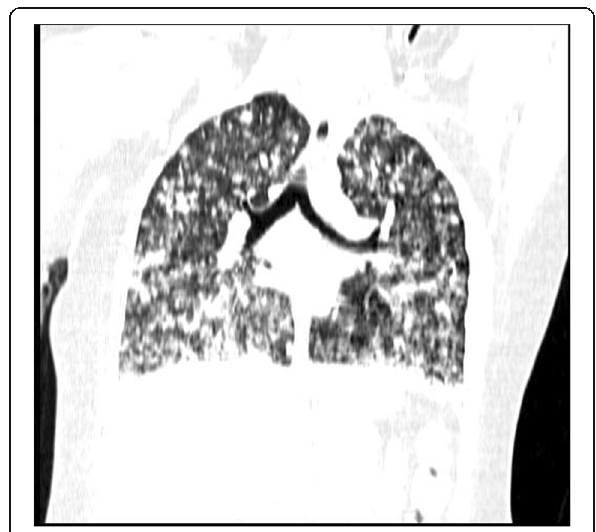
Fig. 3 Coronal reconstruction of chest computed tomography in the lung window demonstrating multiple bilateral solid nodules compatible with metastasis